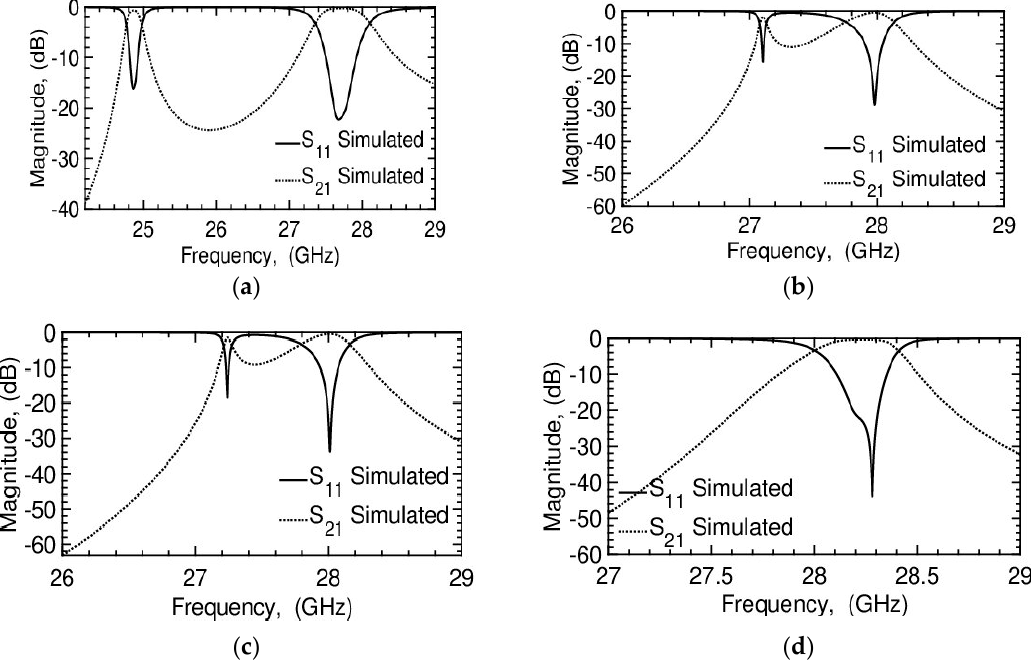
Figure 5. Increasing obstacles for simulated 28 GHz band Rogers 5880 filter: ( a ) one, ( b ) three, ( c ) five, and ( d ) seven obstacle(s).